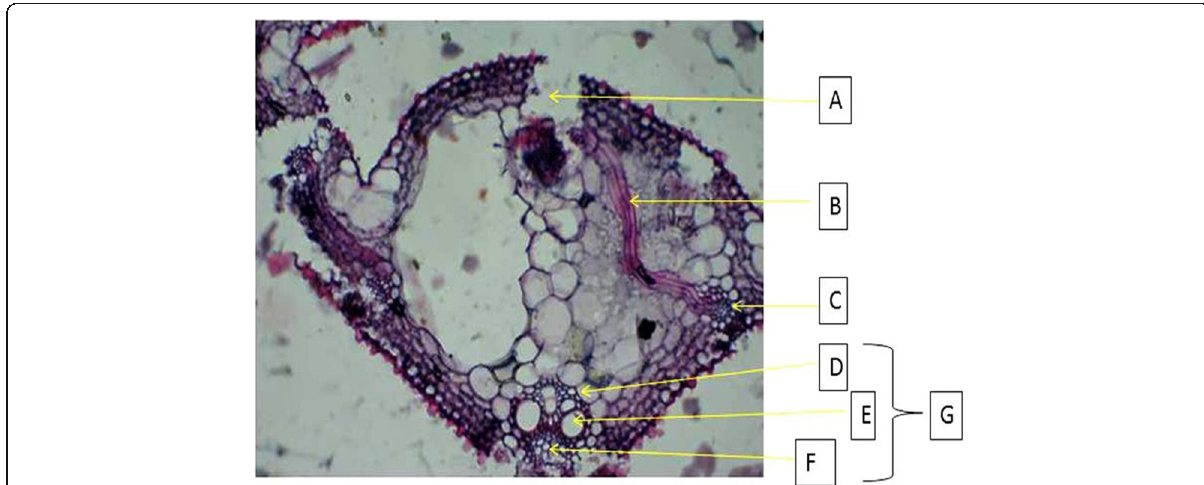
Fig. 5 Light micrograph of cross section of rice leaf epidermal cells showing penetration by Beauveria bassiana . A Destroyed Epidermis was affected by fungi penetration, B Infection hyphae of fungi, C Infected phloem, D Bundle sheath, E Xylem, F Phloem, and G Vascular